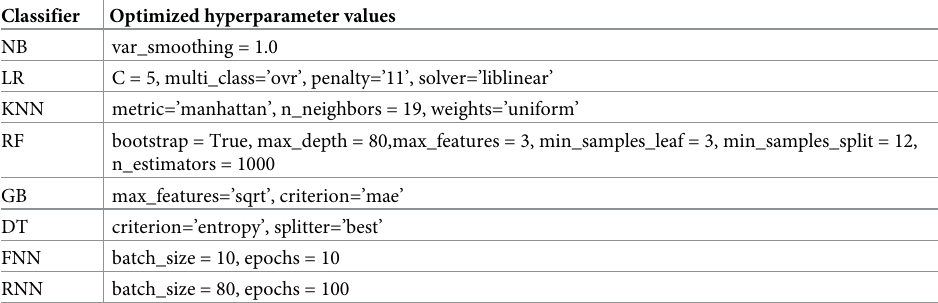
Table 5. Hyperparameter optimization results for different classifiers. All the classifiers are run from the sklern Python package.